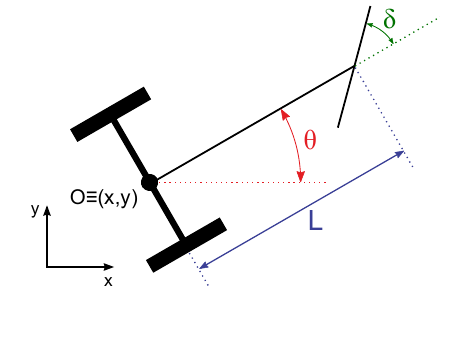
Figure 4. Tractor schematic and description of